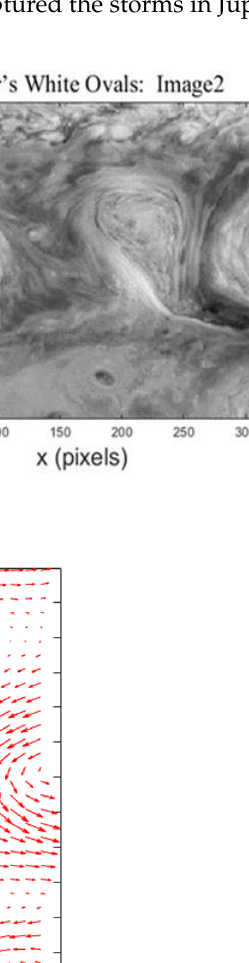
Figure 15. An image pair of Jupiter’s White Ovals.